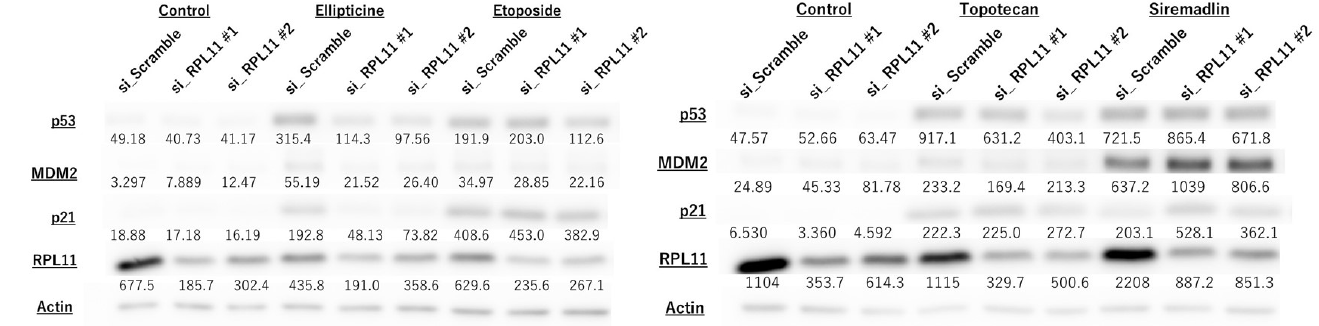
Figure 3. Reduced nucleolar stress response suppresses topoisomerase inhibitor-mediated activation of the p53 pathway in malignant rhabdoid tumor JMU-RTK-2 cells. Cells were transfected with scramble, RPL11#1, and RPL11#2 siRNA and treated with drugs (3 µM Ellipticine, 30 µM Etoposide, 1 µM Topotecan, 1 µM Siremadlin). After 24 h of culture, the cell lysate was subjected to immunoblotting with antibodies against p53, MDM2, p21, RPL11, and actin. Actin was used as a loading control. The numbers below the bands indicate the ratio of the protein/actin expression determined using LuminoGraphII Image Analyzer with CS Analyzer 4 Software. Results represent independent four experiments.